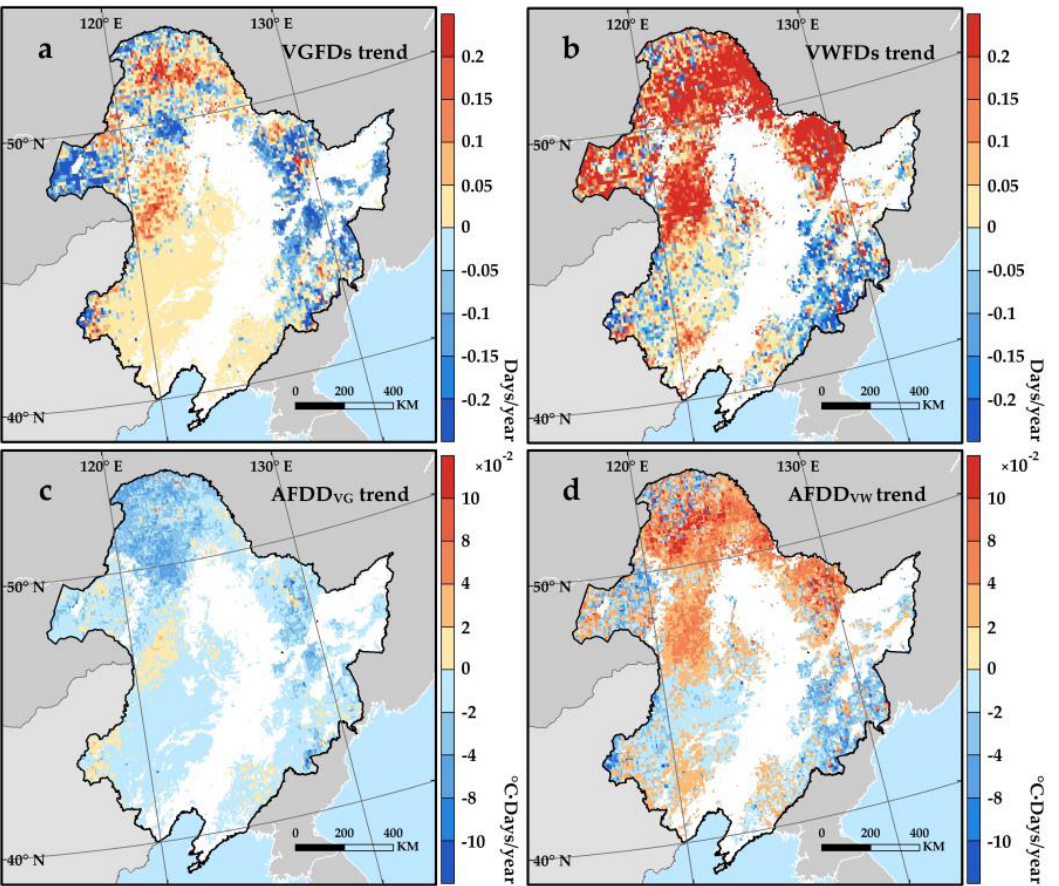
Figure 4. Temporal trends of ( a ) frost days during vegetation greenup (VGFDs); ( b ) frost days during vegetation withering (VWFDs); ( c ) average accumulated frost degree days during vegetation greenup (AFDD VG ); ( d ) average accumulated frost degree days during vegetation withering (AFDD VW ) from 1982 to 2015.